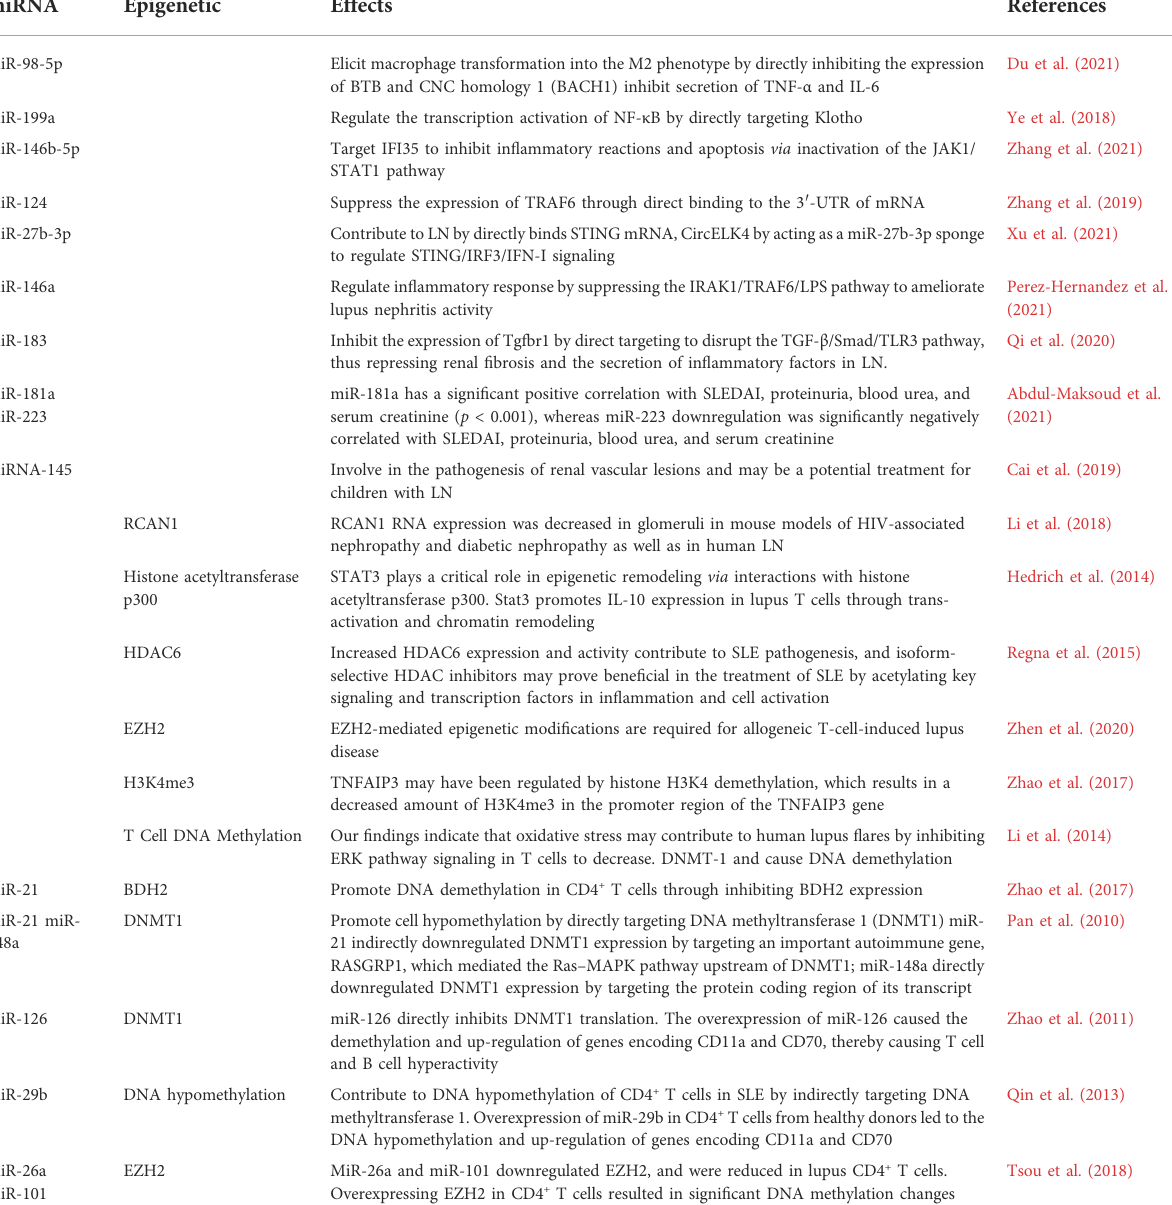
TABLE 4 miRNA expression or alteration in epigenetics on